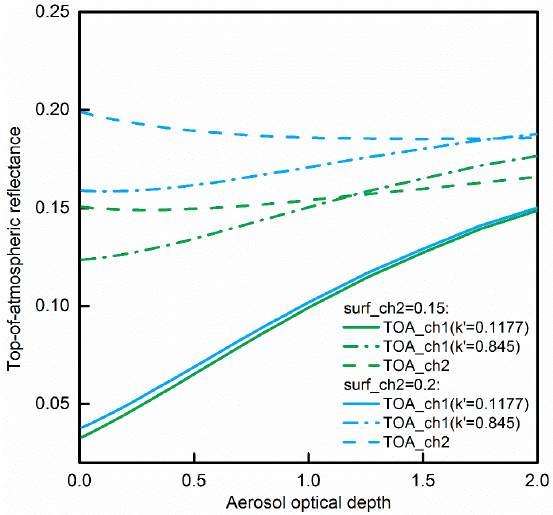
Figure 4. The TOA reflectance at 0.63 and 0.85 μ m as the function of AOD at 0.55 μ m when the solar zenith angle is 22.14°, satellite zenith angle 48°, and relative azimuth angle − 156.41°. The “surf_ch2” indicates a surface reflectance at 0.85 μ m. “ 𝑘′ = 0.1177 ( 𝑘′ = 0.845)” means that the surface reflectance ratio of 0.63 to 0.85 μ m is 0.1177 (0.845).